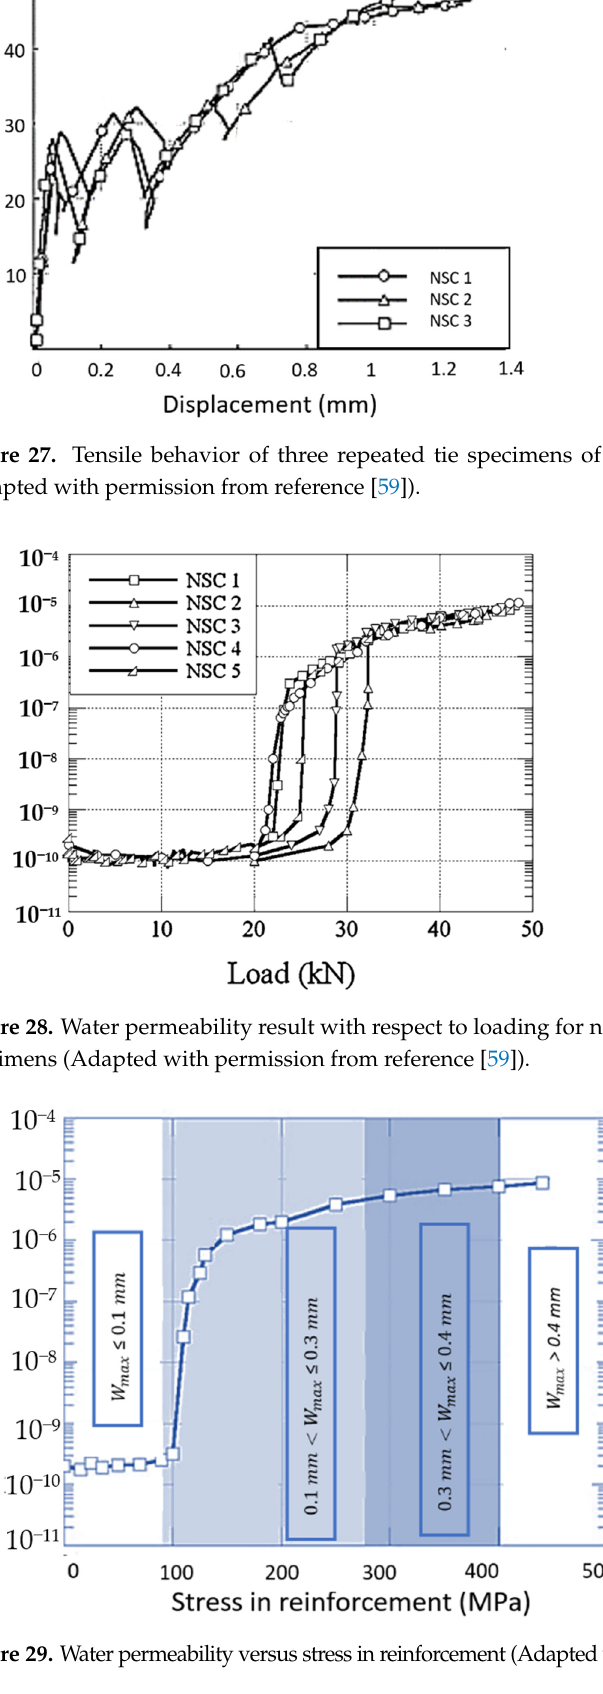
Figure 29. Water permeability versus stress in reinforcement (Adapted with permission from ref- erence